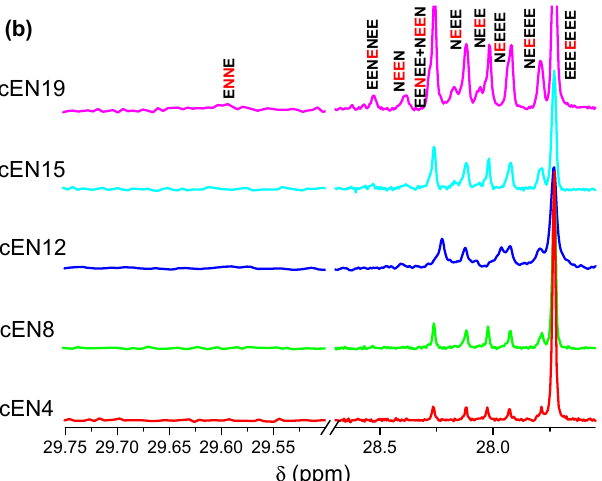
Figure 2. 13 C RMN spectra for the obtained copolymers ( a ), and identification of compositional sequences associated with ethylene (E) and norbornene (N) units ( b ). Table 5. Compositional triads and average length sequences of ethylene for all the prepared copoly- mers.